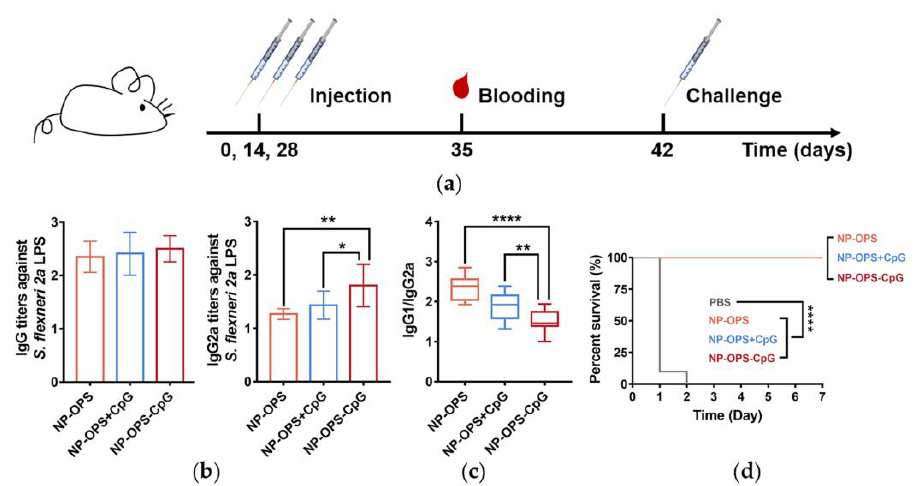
Figure 6. Protection induced by the nanovaccines. ( a ) Immunization schedule for the titer evaluation. ( b ) Total IgG and IgG2a titers against S. flexneri 2a LPS in immunized mice were measured after the third immunization (n = 10). ( c ) The ratio of IgG1 and IgG2a titers was calculated. ( d ) Immunized mice were injected i.p. with the S. flexneri 2a strain (2.5 × 10 7 CFU per mouse) seven days after the final immunization, and their survival was monitored (n = 10). Data are represented as mean ± SD. Each group was compared with NP-OPS-CpG using one-way ANOVA: **** p < 0.0001; ** p < 0.01; and * p < 0.05.